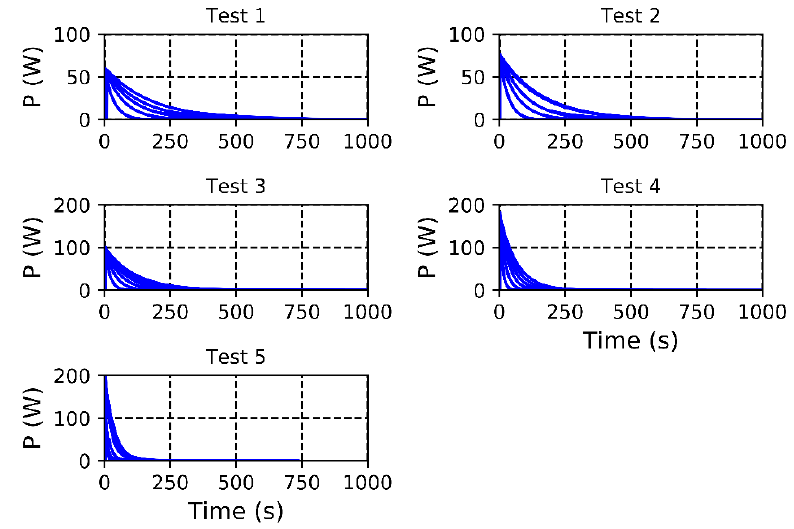
Figure 28. Power while discharging grouped according to the number of the test.